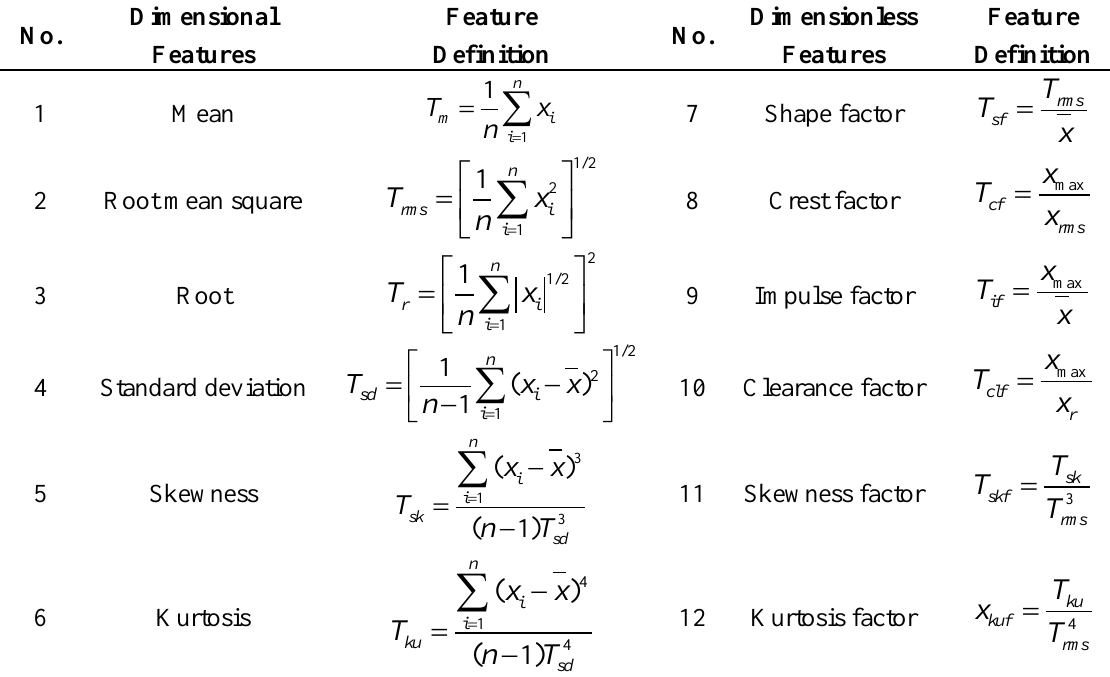
Table 1. Time-domain features.